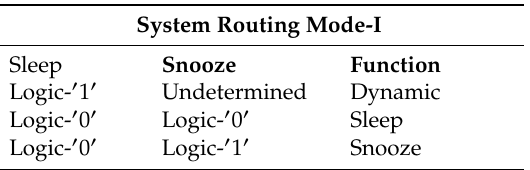
Table 2. Deep learning-assisted system routing mode-I operation.